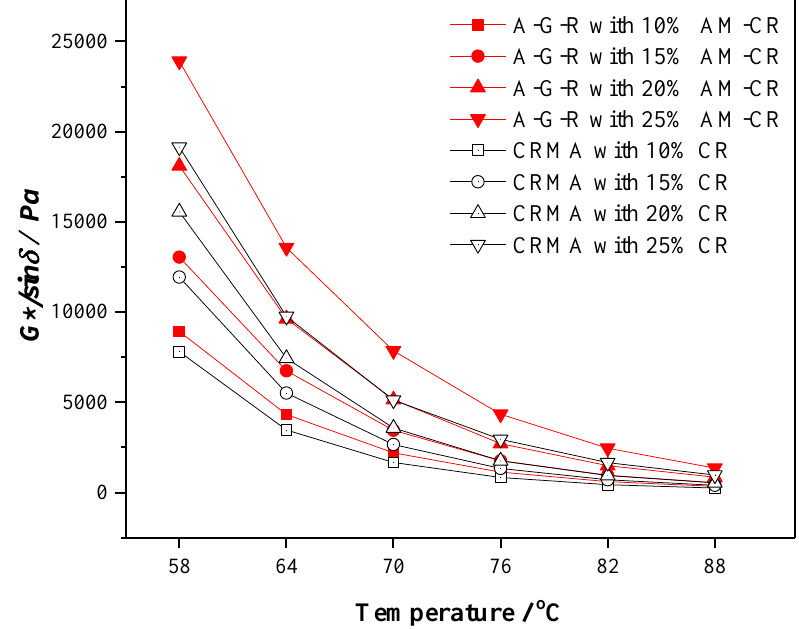
Figure 8. The rutting factor ( G*/sinδ ) of CRMA and A–G–R.